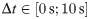
Starting phase influence.Influence of breathing phase at dose delivery beginning. Left, top: In accordance with the measurements, all previous results were computed with the simulations starting at the breathing phase at t = 0 s of the curve (here: case 1b). Now, this starting phase was systematically varied by adding offsets Δt∈[0s;10s]. Left, bottom: The ITV γ-passing rates for comparison of planned static and motion-affected simulated dose distributions are shown as red lines (solid lines: Δα = 2.3°; dashed: Δα = 150°); the black lines visualize the dependence of the difference between dynamic measurement and simulated motion-affected dose on the starting phase. Right: similar information but for the regular real tumor trajectory (case 2a).